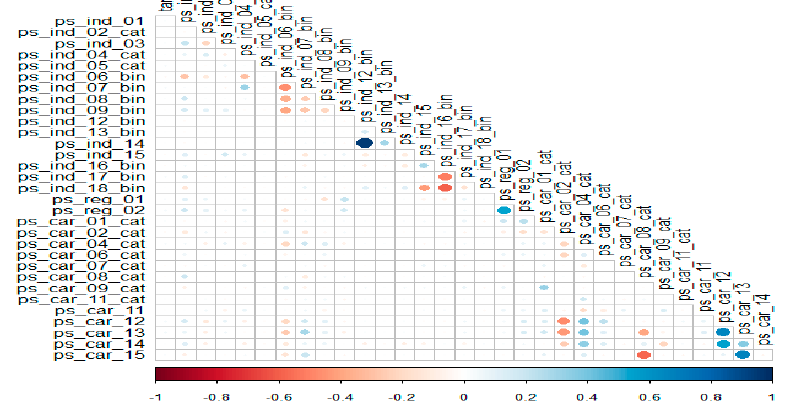
Figure 10. Correlation matrix of data features after we drop calc features.